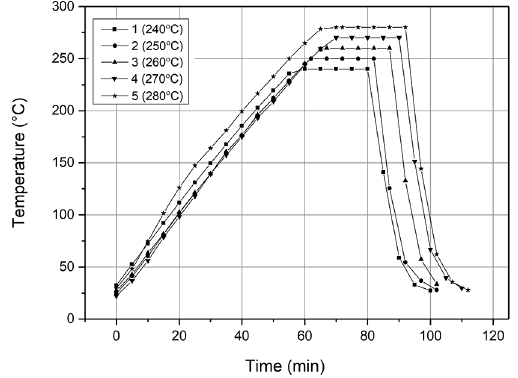
Figure 6. CF/PA commingled composite flat panel processing cycles. (Bibliographic Source: Author.)